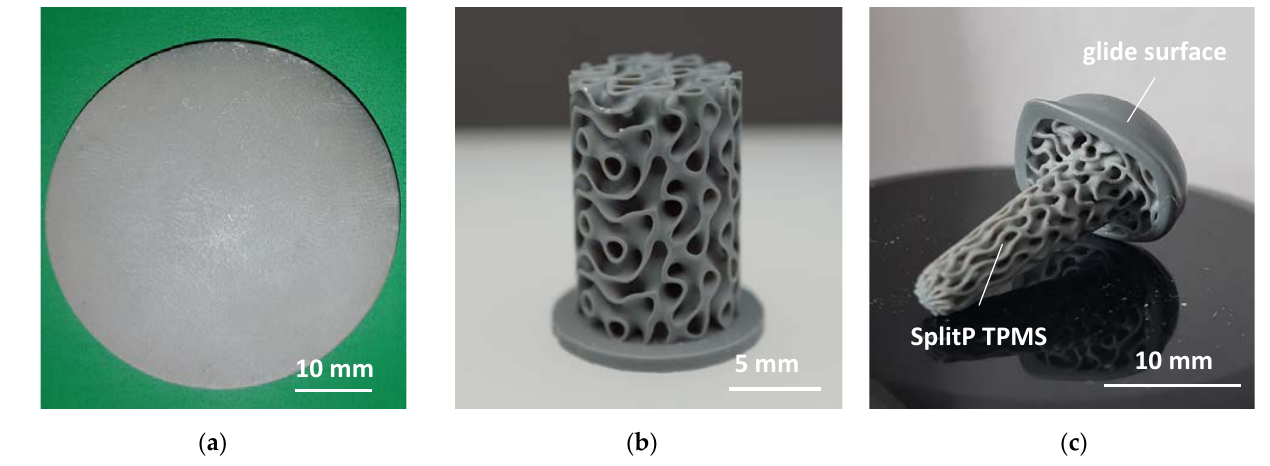
Figure 6. Sintered part of silicon nitride manufactured via CerAM VPP: ( a ) discs for biaxial bending tests; ( b ) a cylindrical TPMS (SplitP design) component on base-plate; ( c ) example of on finger implant with inner dense core, outer porous SplitP structure, and a polished glide surface.